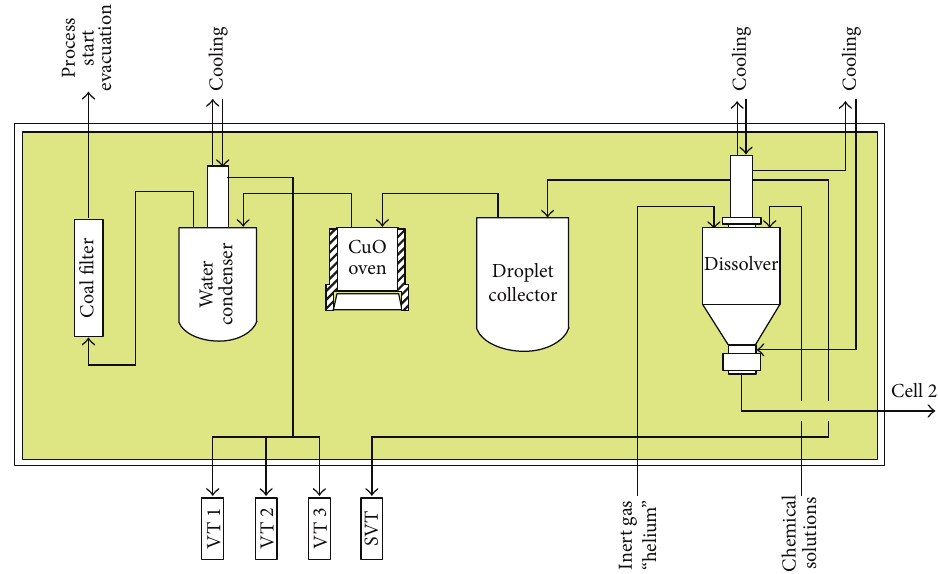
Figure 3: Treatment of the off-gas generated during alkaline digestion of U 3 Si 2 and AlMg1-cladding.